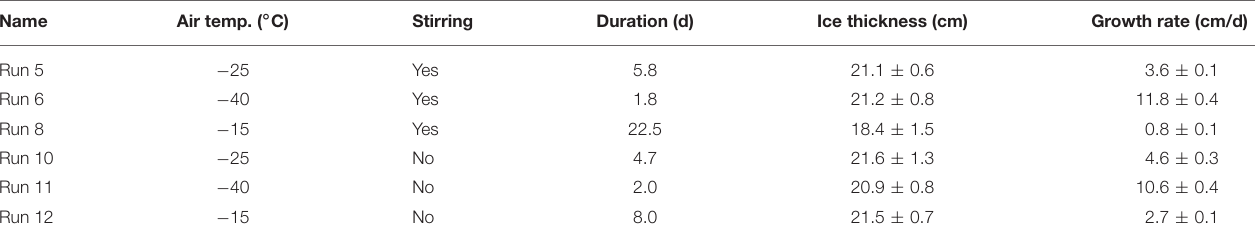
TABLE 3 | Average ice growth rates of all six runs, calculated from the runtime (duration) of each experiment and the average final ice